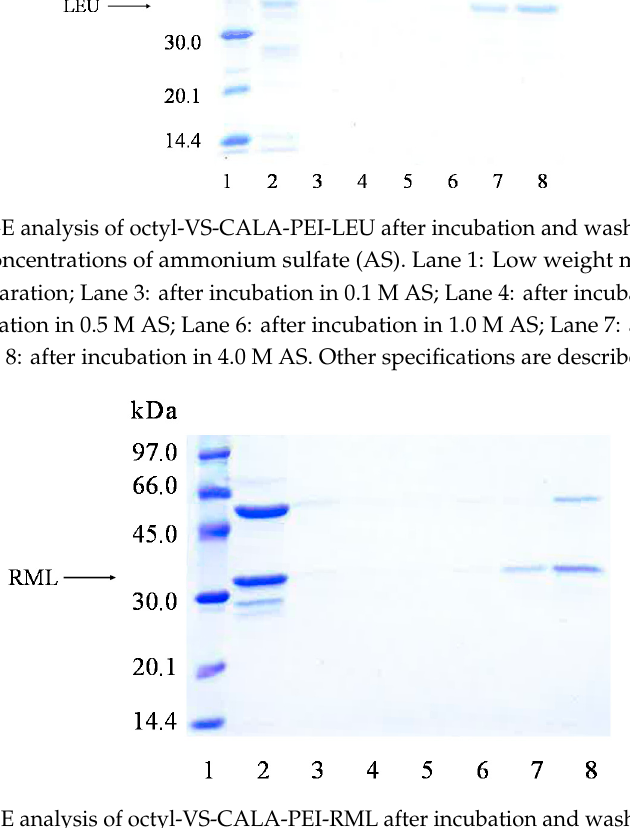
Table 1. Effect of the incubation in solutions presenting different concentrations of ammonium sulfate on the PEI that remained attached to the octyl-VS-CALA biocatalyst, determined by titration of the primary amino groups using 2,4,6-trinitrobenzene sulfonic acid (TNBSA) (see Material and Methods). Ammonium Sulfate, (M) PEI on the Support, (%) 0.1